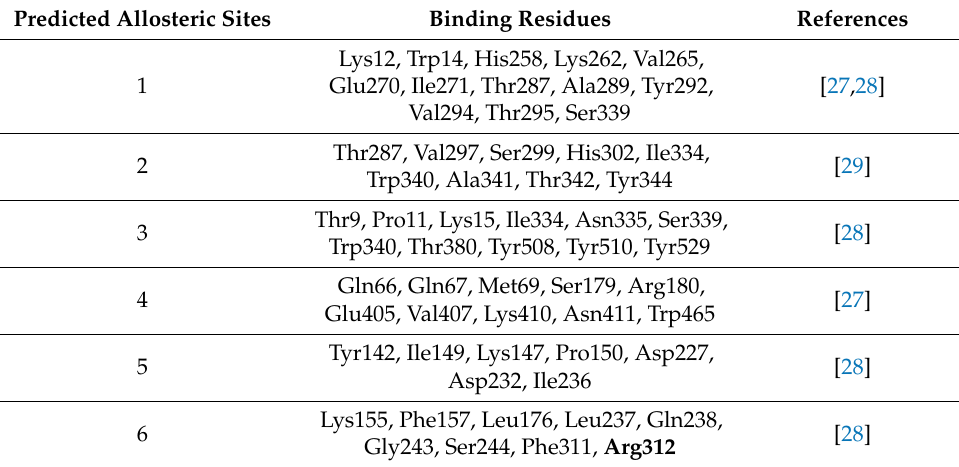
Table 2. Predicted allosteric sites of S. cerevisiae α -glucosidase enzyme. Predicted Allosteric Sites Binding